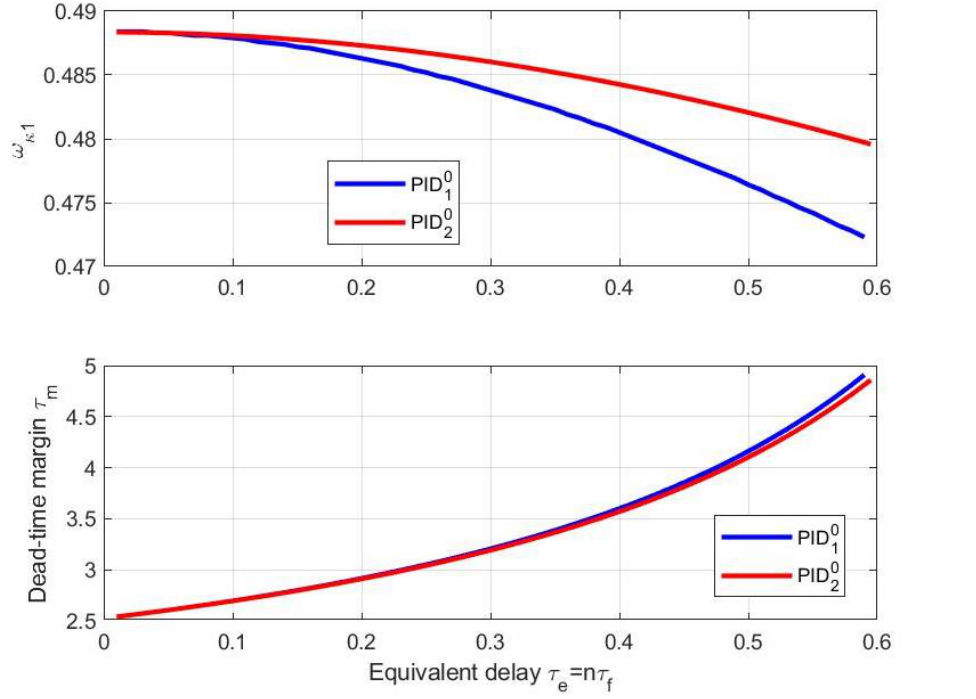
Figure 3. Calculating the dead-time margin τ m of the PID 0 T f = T e / n tuning equivalence, n =